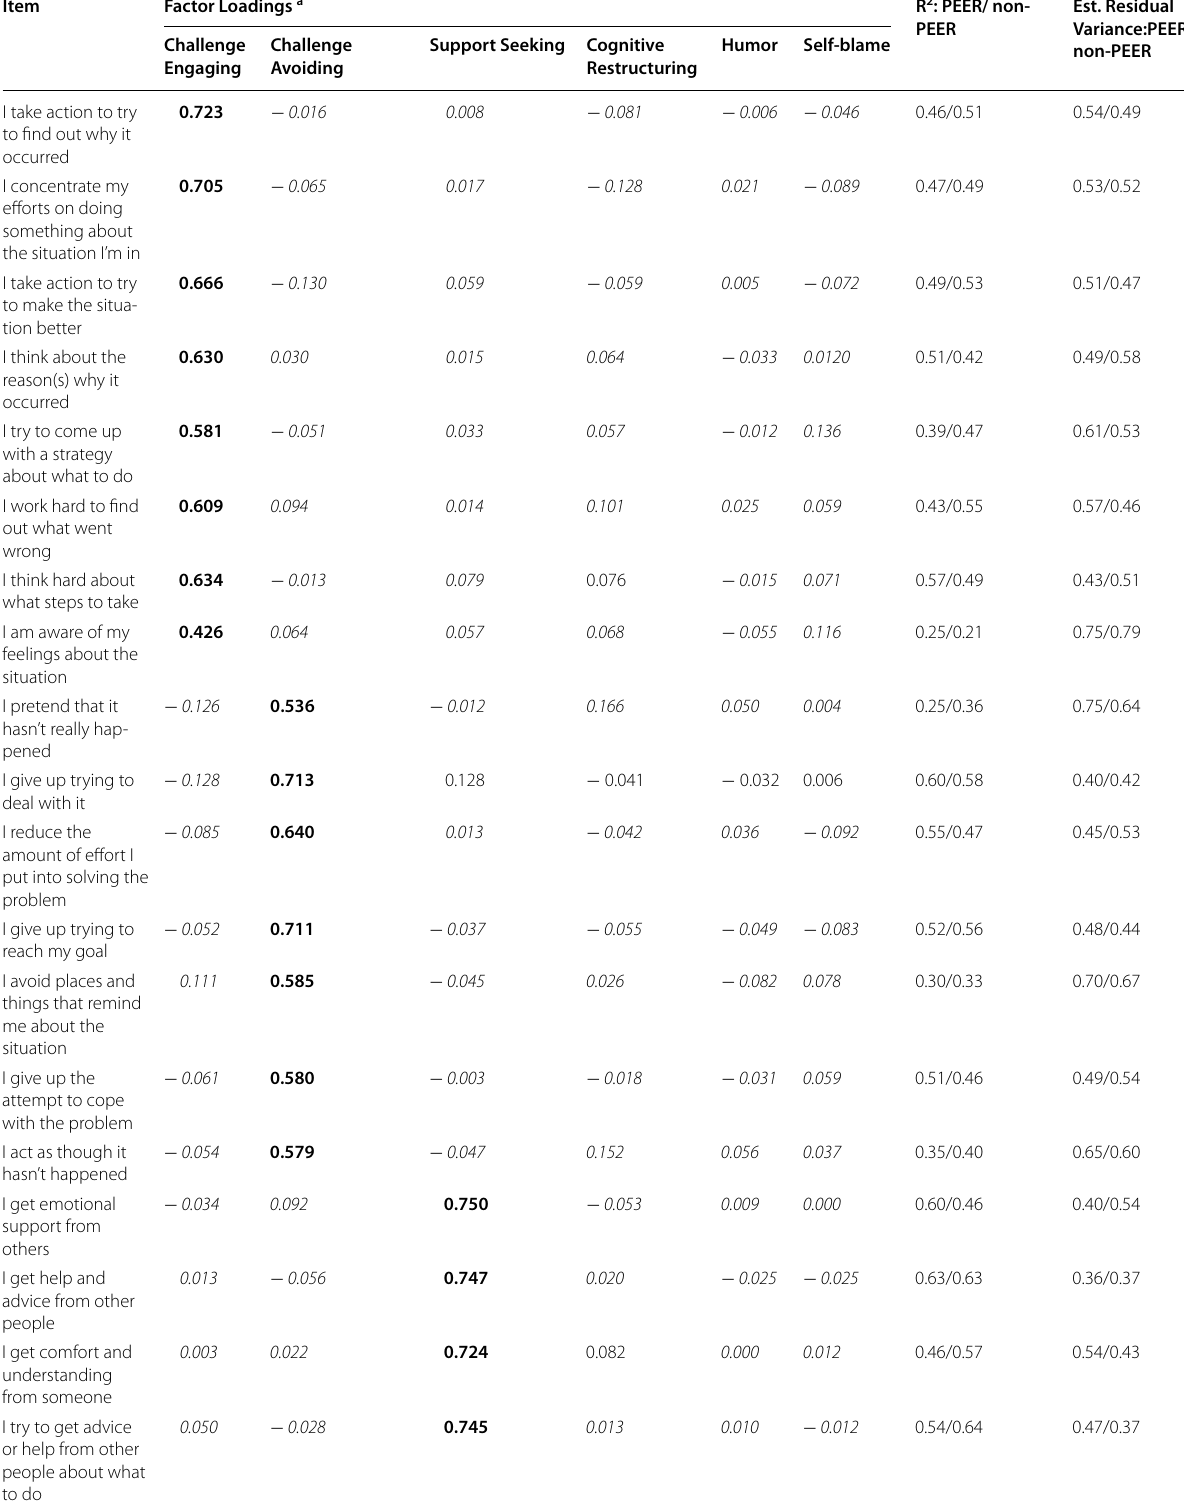
Table 4 Factor loadings for the coping styles